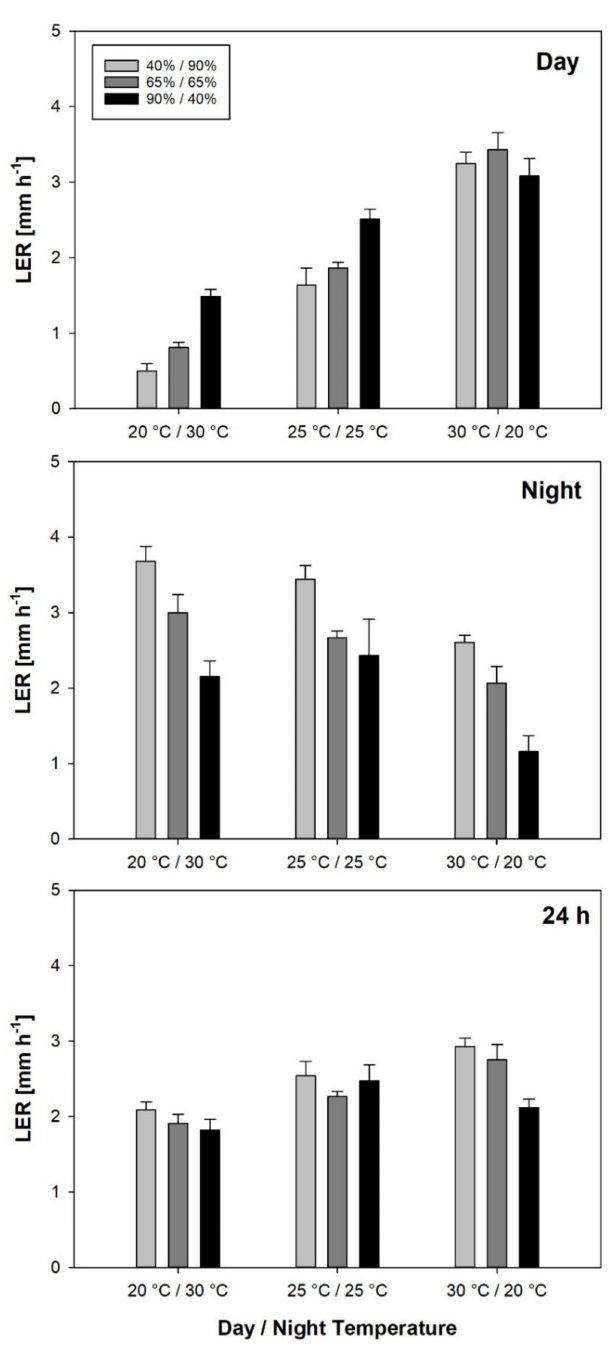
Figure 1. Leaf elongation rate (LER) during day, night and 24 h of plants grown at varying day and night temperatures and RH regimes. Error bars are standard errors of the mean value of 6–8